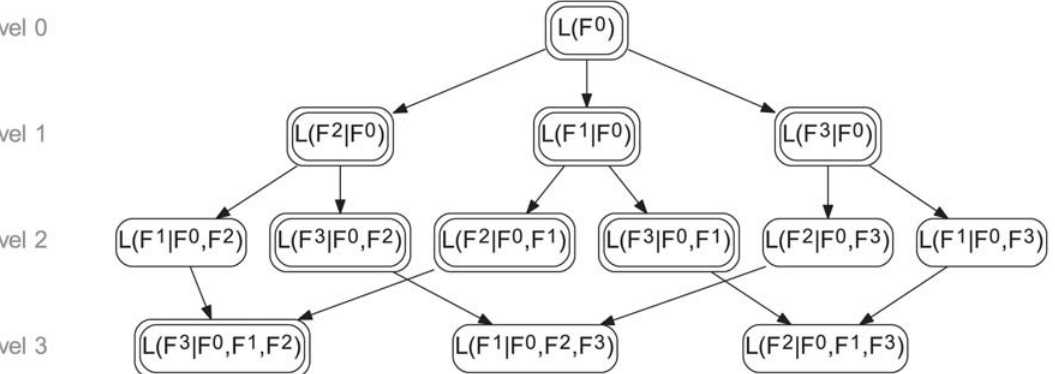
Fig 3. Layering graph with the (conditional) dynamics of N L = 3 functionalities in all orders. The root of the graph at Level 0 represents the initial conditions of the network ( L ( F 0 ) = x 0 , with F 0 = {}). Each path from the root to a leaf represents a different ordering of the functionalities F 1 , F 2 , and F 3 . The nodes correspond to the layers for a given ordering of functionalities. Due to symmetries, only seven of the twelve (conditional) layer dynamics have to be obtained by integration of the respective models of the layers to get to know the dynamics of all layers in all orderings. A possible choice for these layer dynamics is indicated by double boundaries around the respective nodes. The dynamics of the other layers can be obtained by applying Bayes ’ rule. Graph drawn with Graphviz